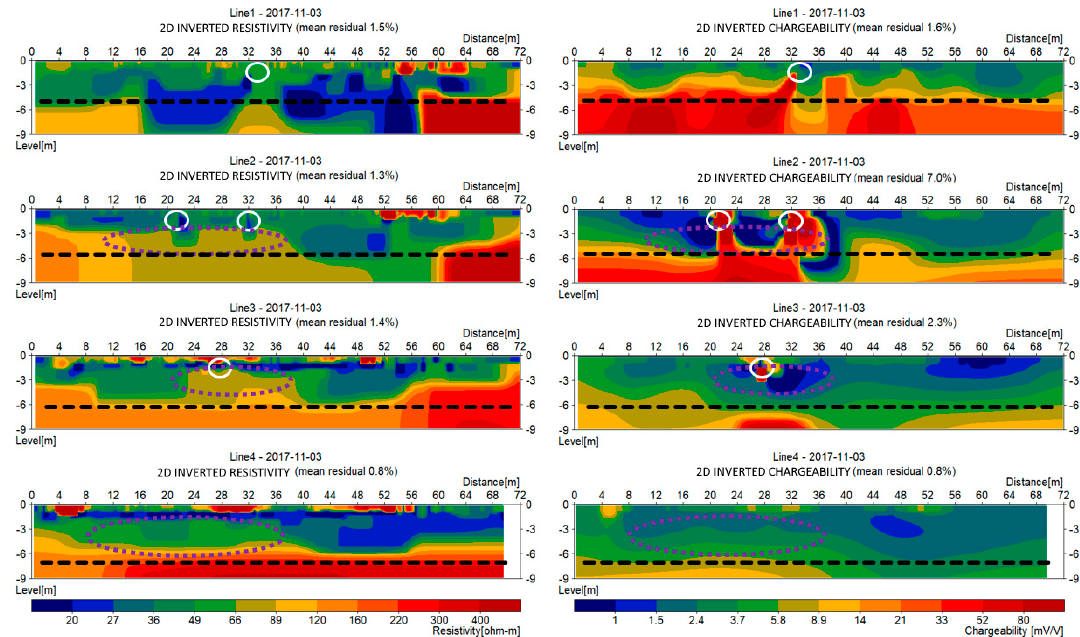
Figure 7. Direct Current resistivity ( left ) and time-domain Induced Polarization ( right ) results for Line 1 (top) to Line 4 (bottom) measured 3rd of November 2017 before the injections took place. For profile location, see Figure 3. The purple dashed line indicates the contamination plume, the white circles indicate the position of known metal pipes and the black dahsed line indicates the sediment to bedrock interface based on the joint interpreation of the conceptual model and the geophyiscal results.